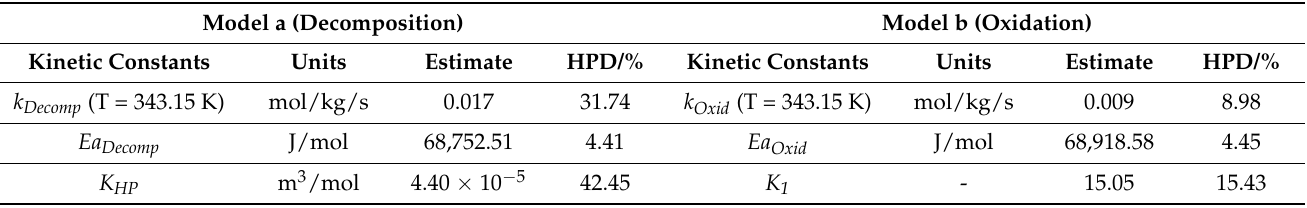
Table 4. Estimated kinetic constants and credible intervals for Models a and b for the homogeneous liquid phase system. Model a (Decomposition) Model b (Oxidation) Kinetic Constants Units Estimate HPD/% Kinetic Constants Units Estimate HPD/% k Decomp (T = 343.15